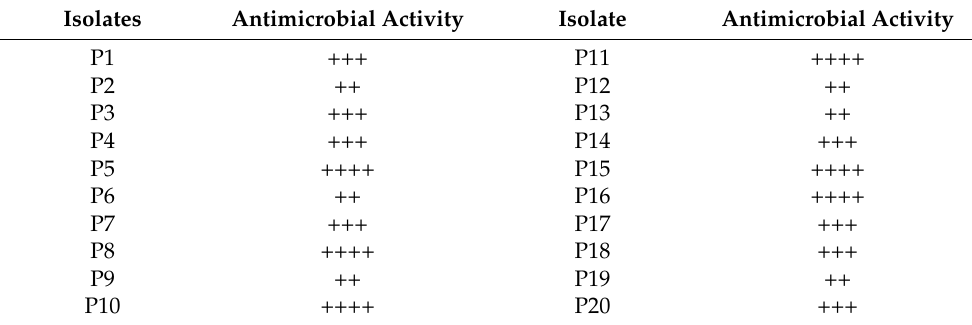
Table 2. Antimicrobial activities to ETEC K88 of representative LAB isolates. Isolates Antimicrobial Activity Isolate Antimicrobial